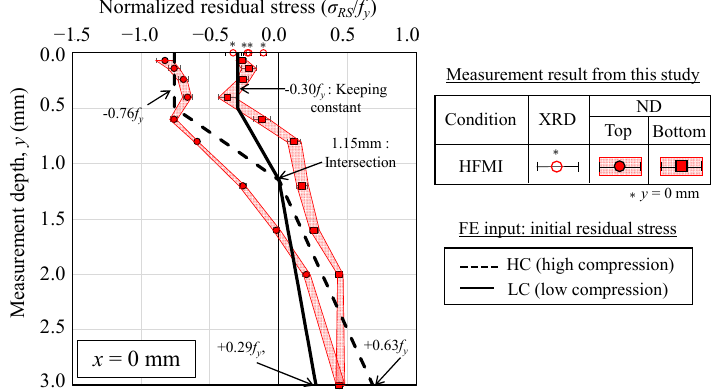
Figure 10. Experiment-based in-depth residual stress distribution at x = 0 mm.